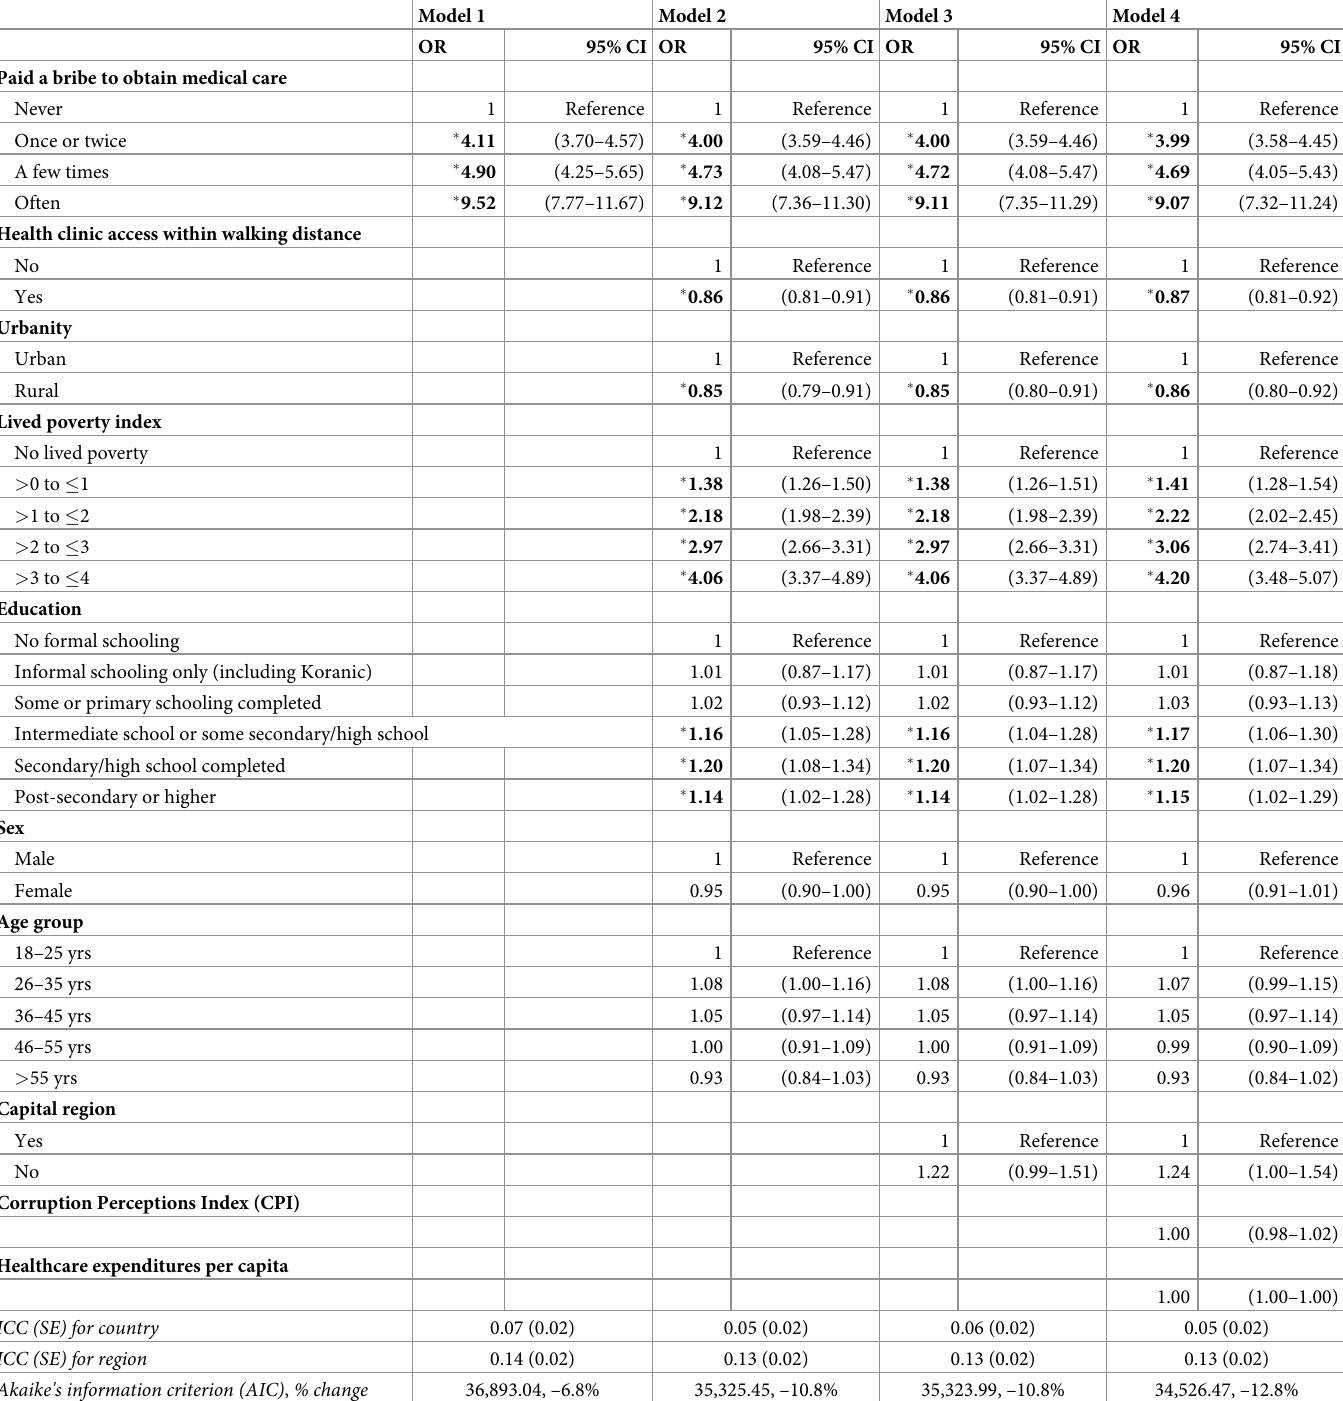
Table 2. Odds ratio and 95% confidence intervals for associations between having paid a bribe to obtain medical care and perceived difficulty of obtaining medical